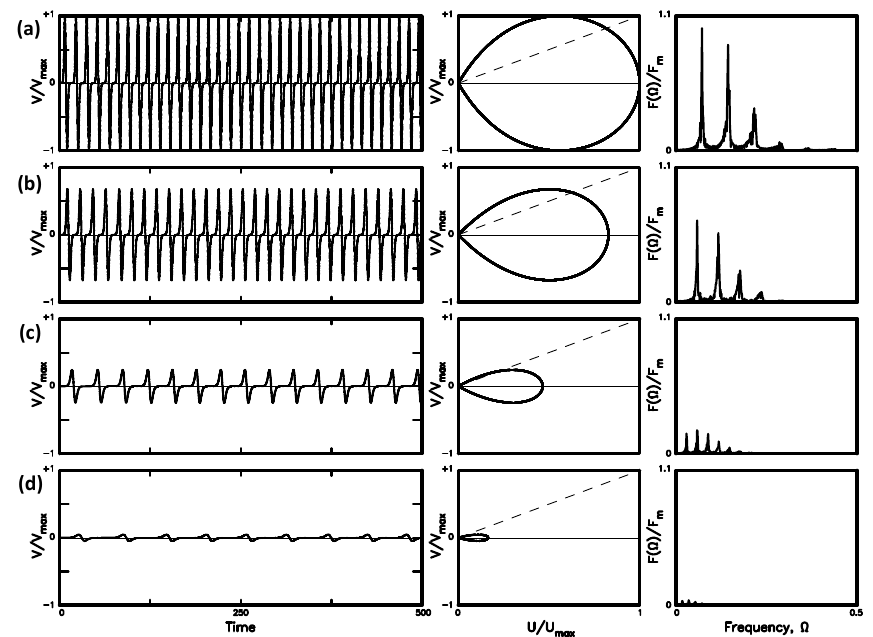
Figure 5. The time variation in V/V max , the phase portrait of V/V max versus U/U max , and the power spectrum for four values of U c : (a) for U c = 0 . 1; (b) for U c = 0 . 4; (c) for U c = 0 . 7; and (d) for U c = 0 . 9 for the TP law of F(U) = exp ( − U/U c ) when η = 0.